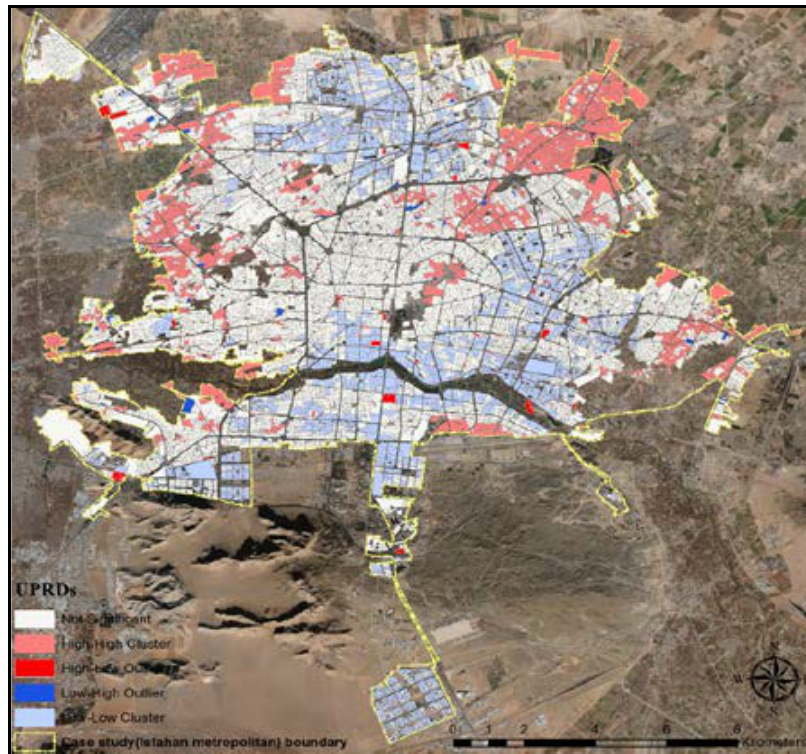
Fig. 9: Determining UPRDs through cluster and outlier analysis